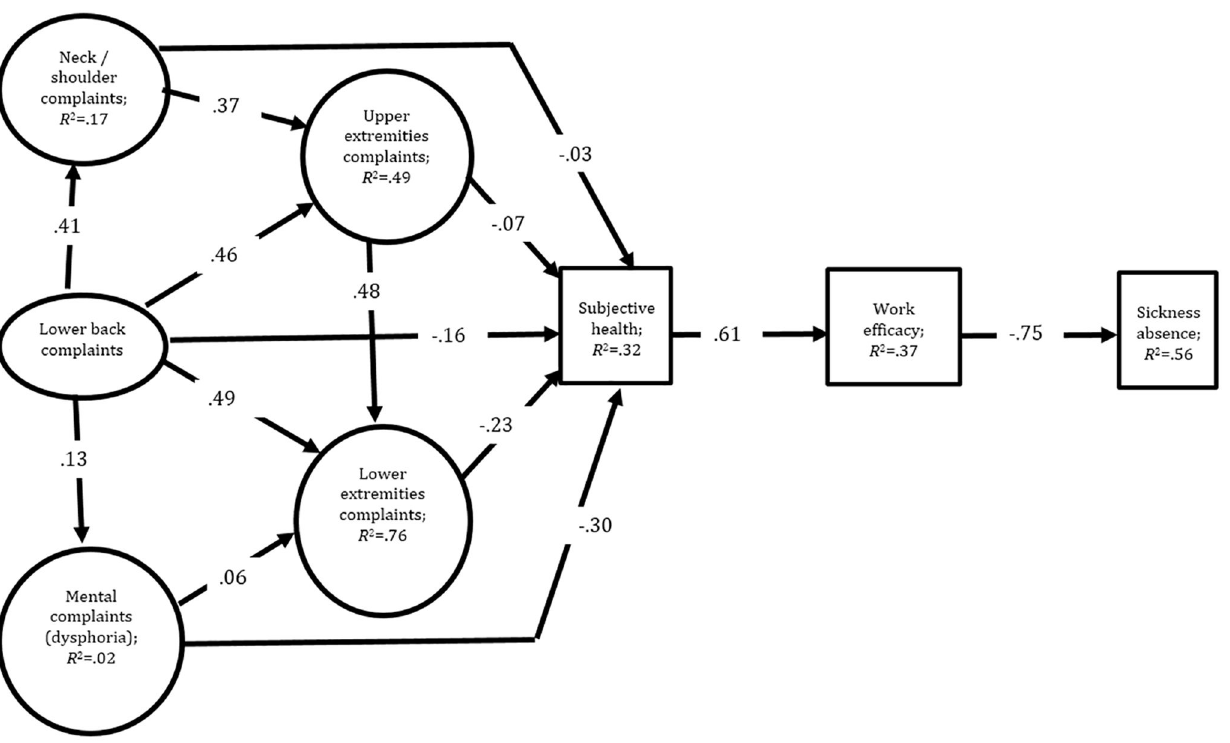
Figure 1. Standardized parameter estimates are given for the structural model. All paths are significant at or beyond p < .001. Note that the explained variance in each given path is calculated as the squared estimate. Factor loadings for the indicators of latent variables (ovals) are given in the method